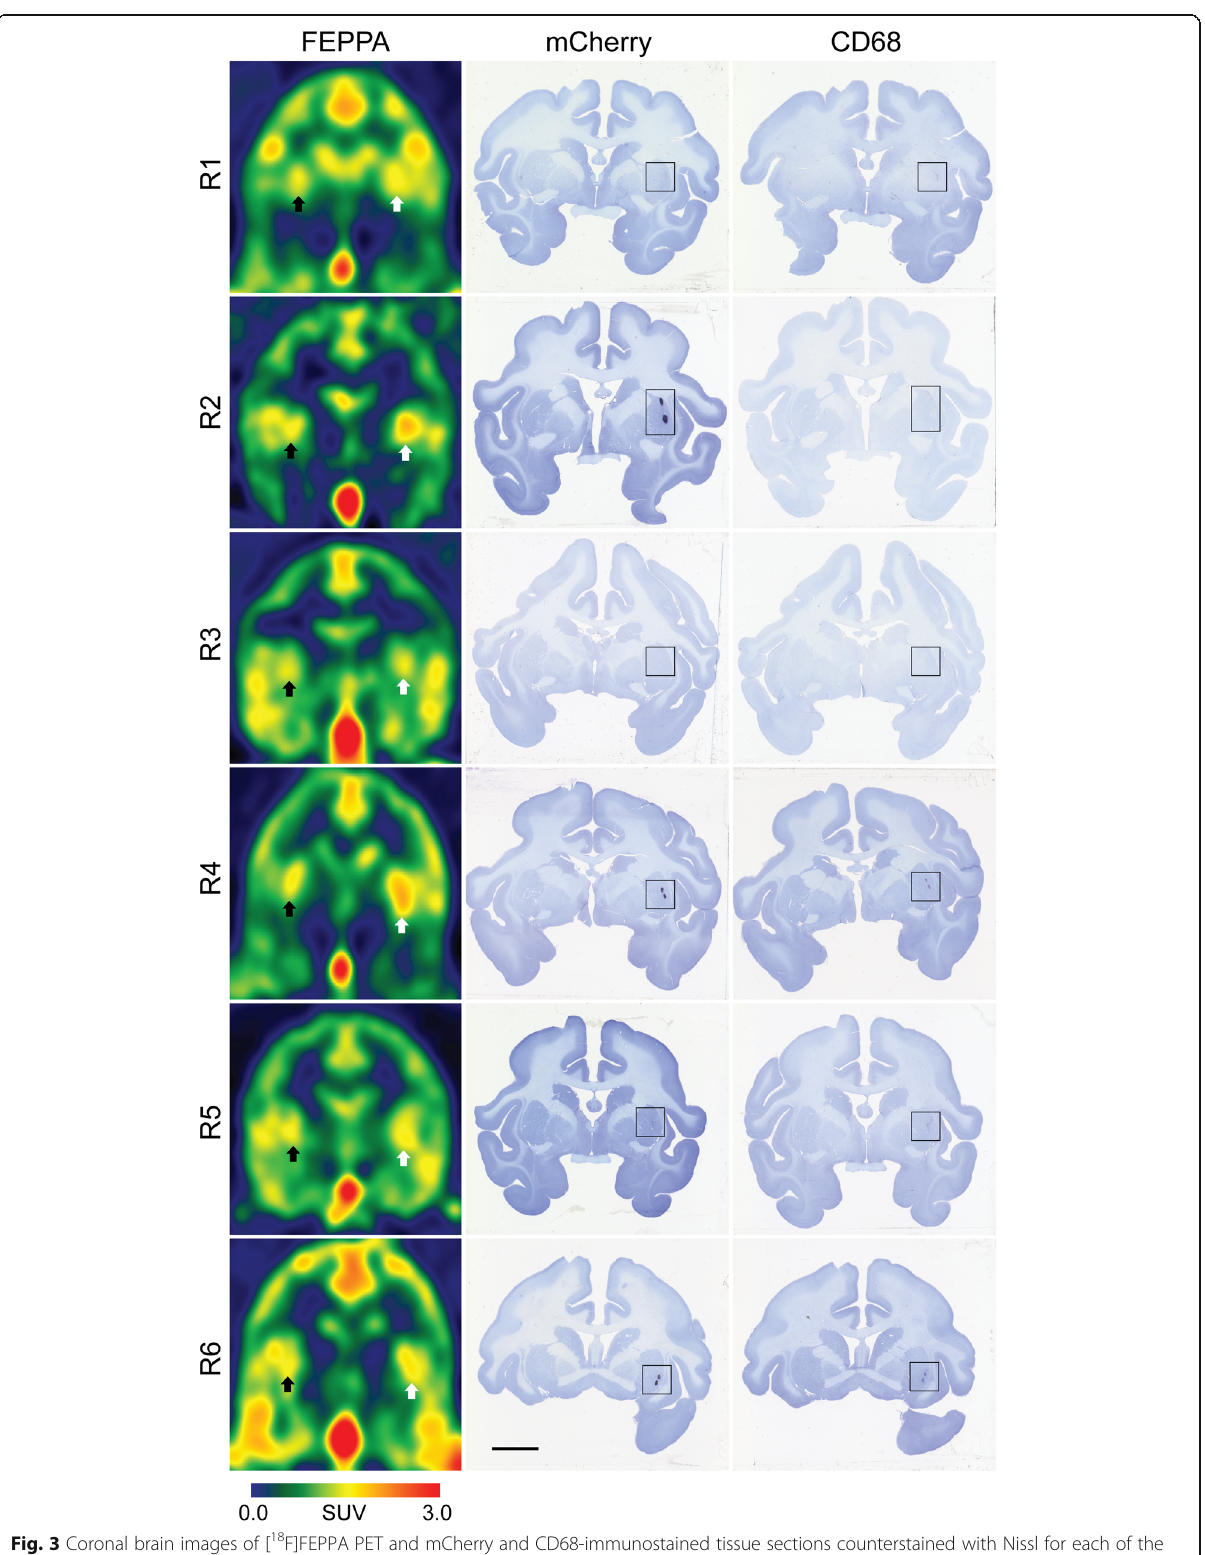
Fig. 3 Coronal brain images of [ 18 F]FEPPA PET and mCherry and CD68-immunostained tissue sections counterstained with Nissl for each of the six animals. Arrows point to the contralateral (left, black arrow) and ipsilateral (right, white arrow) putamen; black squares demarcate grafted immunoreactive area. Scale bar: 1